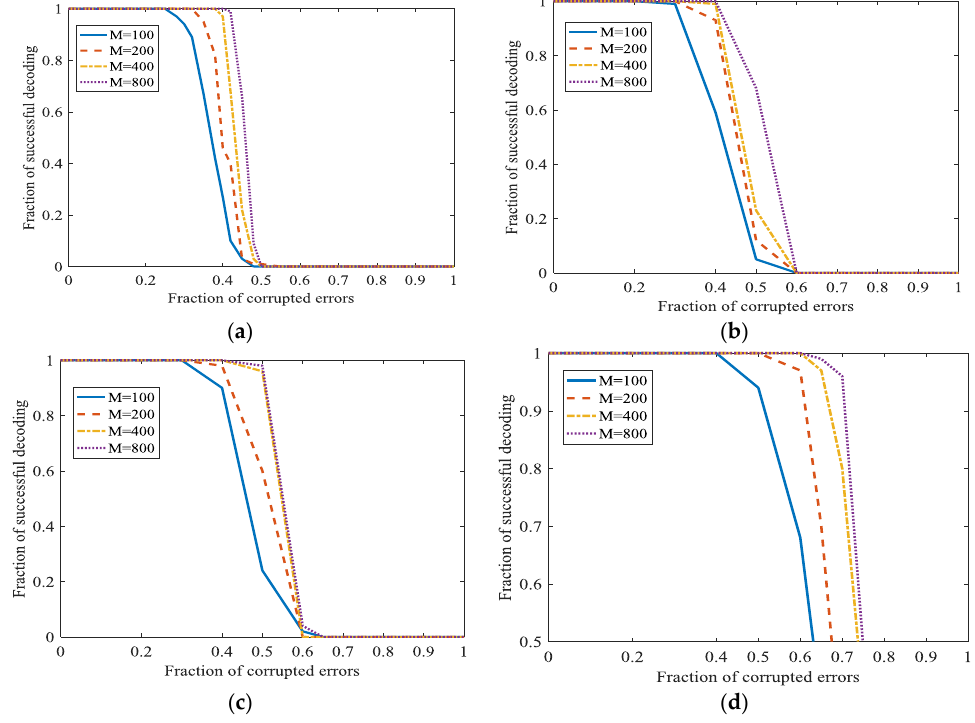
x m  at different  . ( a ) 0